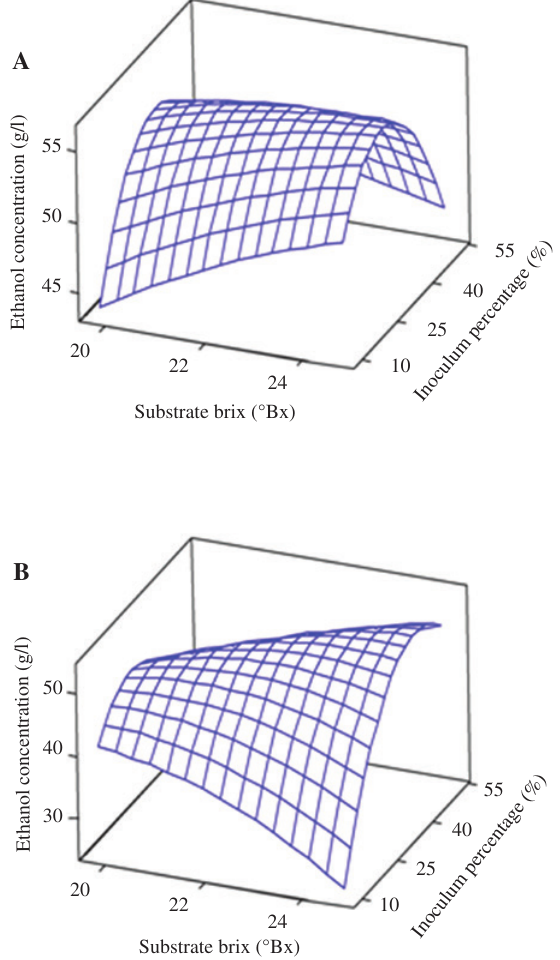
Figure 1: Surface plots of the concentration of the produced bioethanol (g/l) as function of the substrate brix ( ° Bx) and inoculum percentage (%), during fermentation using the yeast strains (A) SFO6 and (B) NCYC